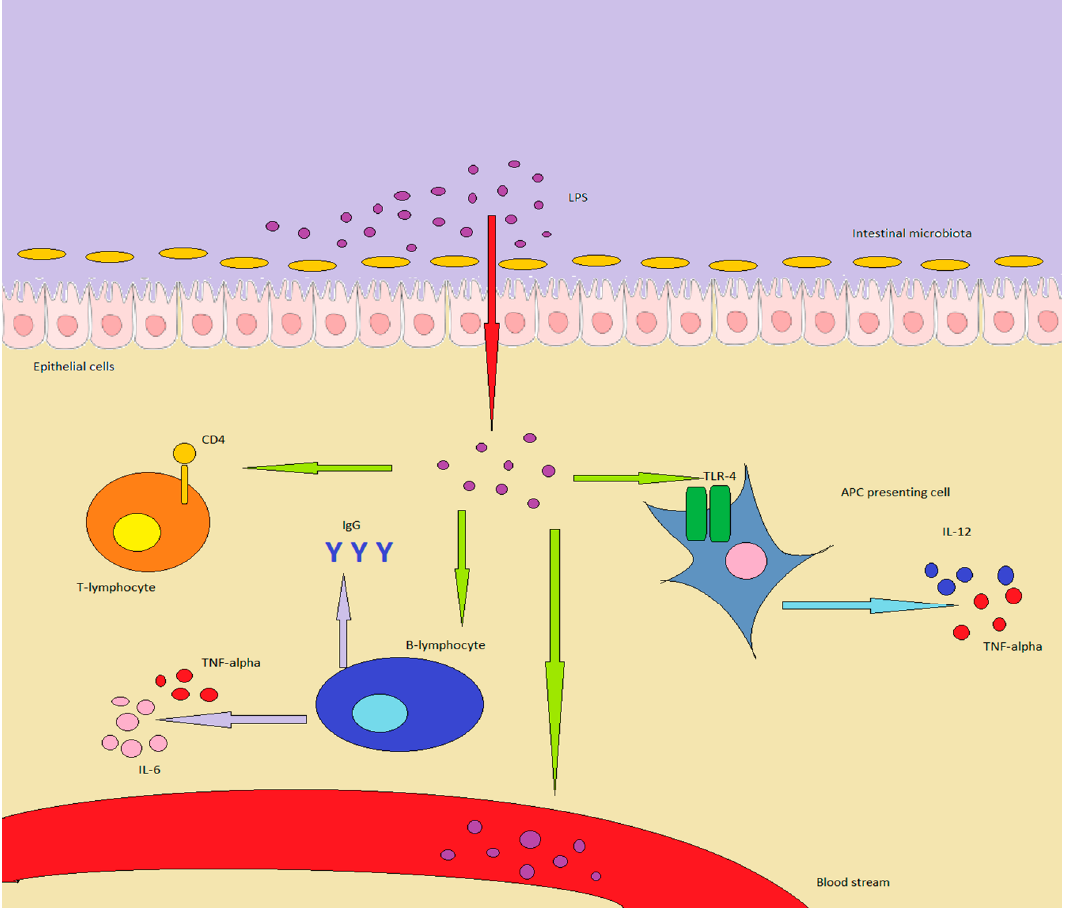
Figure 1. LPS in healthy individuals is produced by GM or enters through food. In inflammatory conditions or in a “leaky gut”, it can overcome the epithelial barrier, determining important effects on the immune system: in particular, APC are stimulated to produce TNF-alpha and IL-12. B-lymphocytes increase antibody production, while also producing TNF-alpha and IL-6, while T-lymphocytes are shifted towards a Th1/Th17 expression pattern. Finally, LPS can enter the bloodstream, inducing chronic or acute endotoxemia.